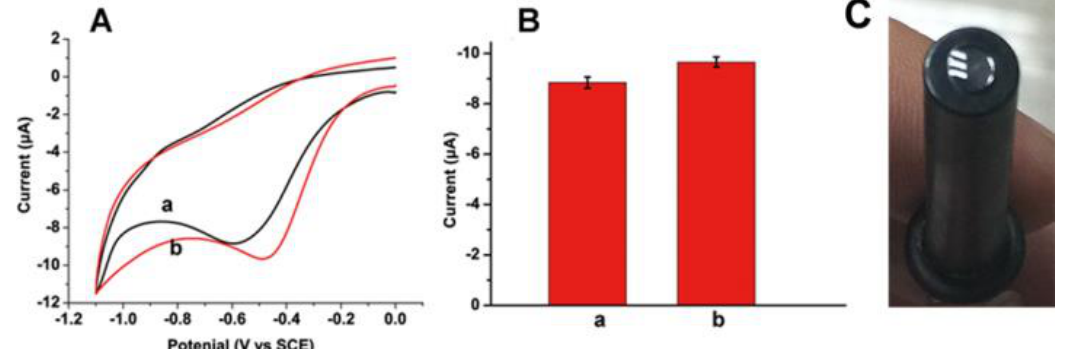
Figure 3. ( A ): Cyclic voltammograms of ( a ) non-N-doped CDs modified electrode and ( b ) N-doped CDs modified electrode in air-saturated 0.1 M pH 7.0 PBS. Scan rate: 100 m·Vs −1 ( B ): Electrochemical